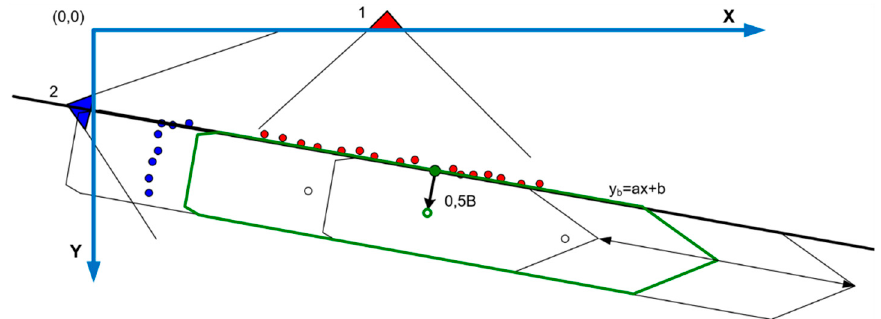
Figure 10. Estimation of ship’s position from LIDARs measurements.